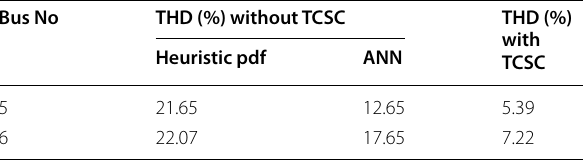
Table 15 THD of real power flow with and without TCSC for IEEE 9- bus system at bus 5 & 6